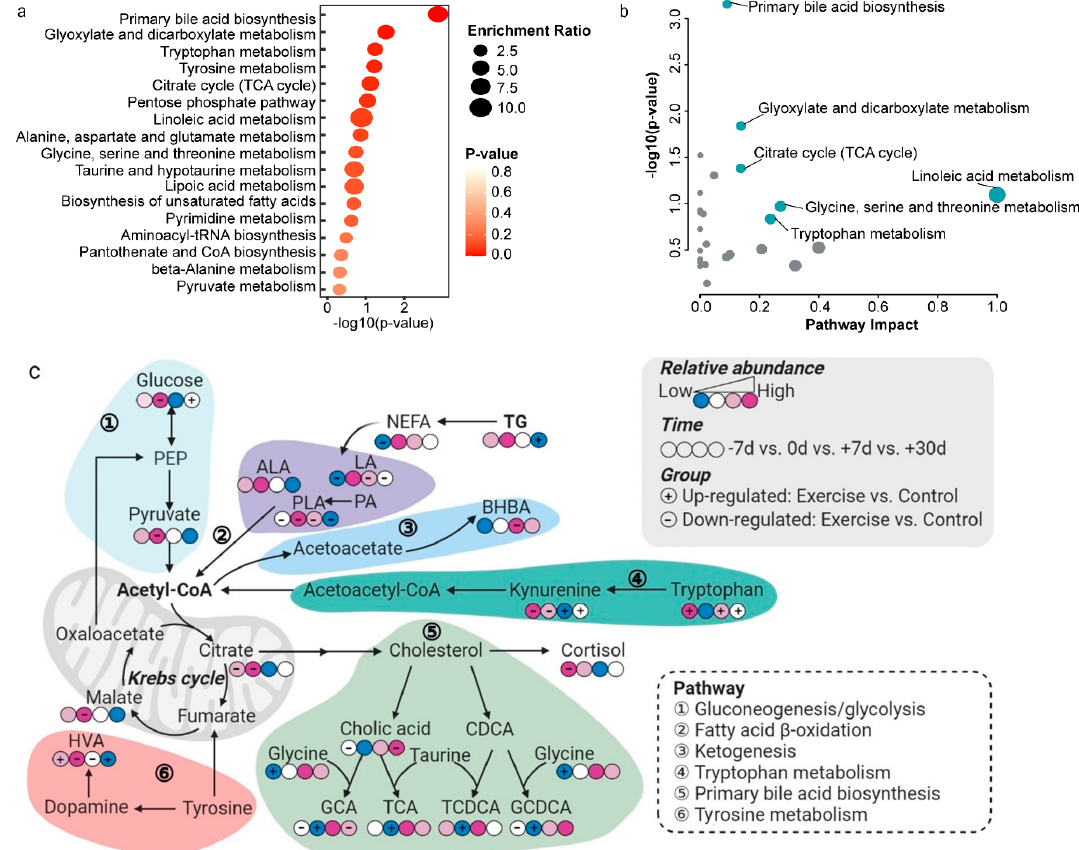
Figure 4. KEGG pathway analysis and dynamic changes in the plasma levels of differential metabo- lites. ( a ) KEGG enrichment analysis of 29 differential metabolites identified in control group cows; the circle size represents the enrichment ratio. The p value is represented in terms of color in which a deeper color (red) of circles represents a decreasing trend. ( b ) Pathway analysis of 29 differential metabolites identified in control group cows using topology analysis; the circle size represents the pathway impact. ( c ) Metabolic pathways involving major metabolites that differed in plasma con- centration between the exercise and control cows at –7 d, 0 d, +7 d, and +30 d relative to calving. Four circles indicate the metabolites identified in control group cows at –7 d, 0 d, +7 d, and +30 d relative to calving. The color of circles indicates the relative abundance of the metabolite in which blue (red) circles represent low (high) relative abundance. The symbol “+“ indicates that the metab- olite concentrations are higher in the exercise group than in the control group, and the symbol “-” indicates that the metabolite concentrations are lower in the exercise group than in the control group. NEFA = non-esterified fatty acids; BHBA = β -hydroxybutyric acid; TG = triglyceride; PEP = phosphoenolpyruvate; ALA = arachidonic acid; PLA = palmitoleic acid; LA = linoleic acid; PA = palmitic acid; HVA = homovanillic acid; GCA = glycocholic acid; TCA = taurocholic acid; CDCA = chenodeoxycholic acid; TCDCA = tauroursodeoxycholic acid; GCDCA = glycochenodeoxycholic acid. The figure was created with BioRender (https://biorender.com/) . 2.4. Key Metabolites and Correlation Analysis The following six metabolites were identified to be commonly changed in the exer- cise and control groups over the four time points (Figure 5a): gentisic acid, m-coumaric acid, kynurenine, myo-inositol, homovanillic acid, and cis-9-palmitoleic acid (Figure 5b). The cis-9-palmitoleic acid level in cows of the exercise group was consistently lower than that in the control cows. The kynurenine level in cows of the exercise group was low be- fore calving and was high after calving when compared with those in the control cows. The gentisic acid level in cows of the exercise group was higher than that in the control